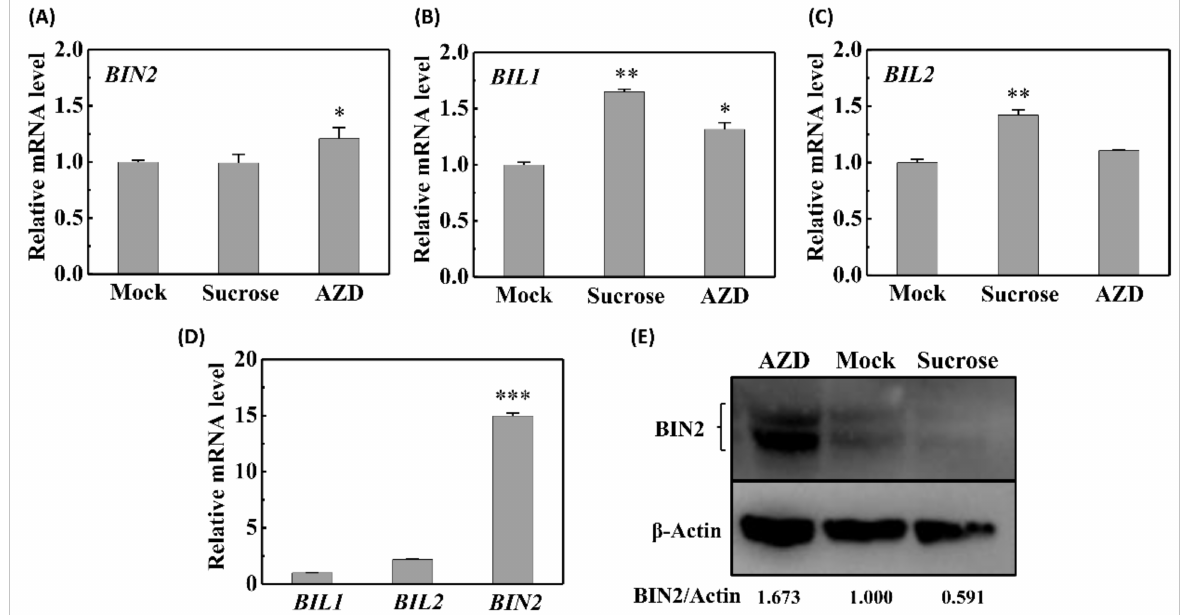
Figure 4. Sucrose influences the mRNA levels of GSK3 s and the protein abundance of BIN2. Expression patterns of the BIN2 ( A ), BIL1 ( B ), and BIL2 ( C ) genes in wild-type (WT) etiolated seedlings treated with 30 mM sucrose or 1 µ M AZD. ( D ) Comparison of the mRNA levels of BIN2 , BIL1 , and BIL2 in untreated WT etiolated seedlings. Values are presented as the means ± SD of three independent sets of experiments. ( E ) Immunoblot analysis of BIN2 protein in WT etiolated seedlings grown in the dark on medium supplemented with 30 mM sucrose or 1 µ M AZD. Data were statistically evaluated using Student’s t-test, and the significance of differences (*, p < 0.05; **, p < 0.01; ***, p < 0.001) is